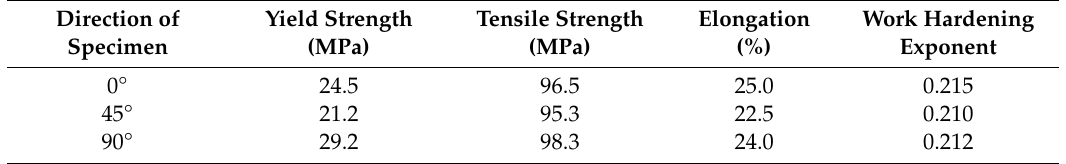
Table 1. Mechanical properties of Al1060.